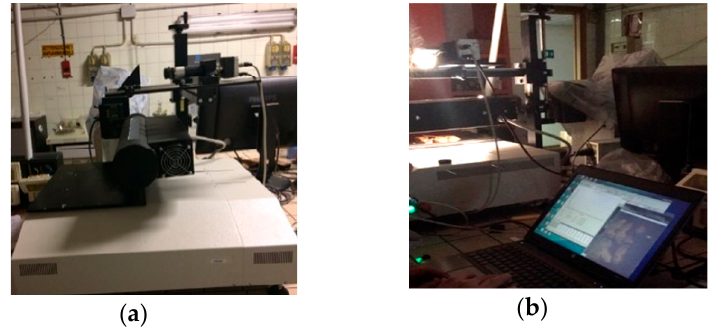
Figure 2. The DV spectral scanner (DV Srl, Padova, Italy). ( a ) System turned o ff ; ( b ) system turned on, coupled with dedicated software.